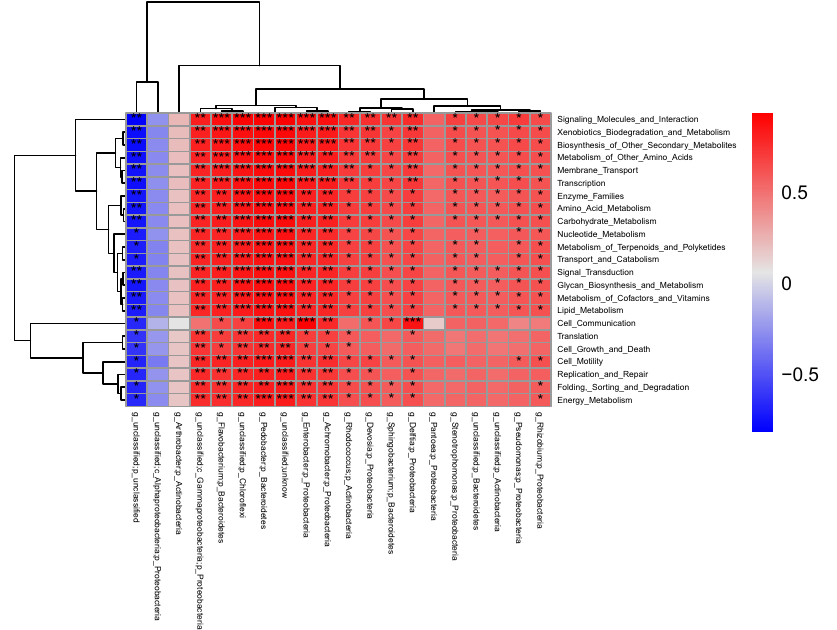
Figure 8. KEGG pathways with significant differences among the four Allium species were highly correlated with bacterial genera with significant differences. * 0.01 < p < 0.05, ** 0.001 < p < 0.01, *** p <